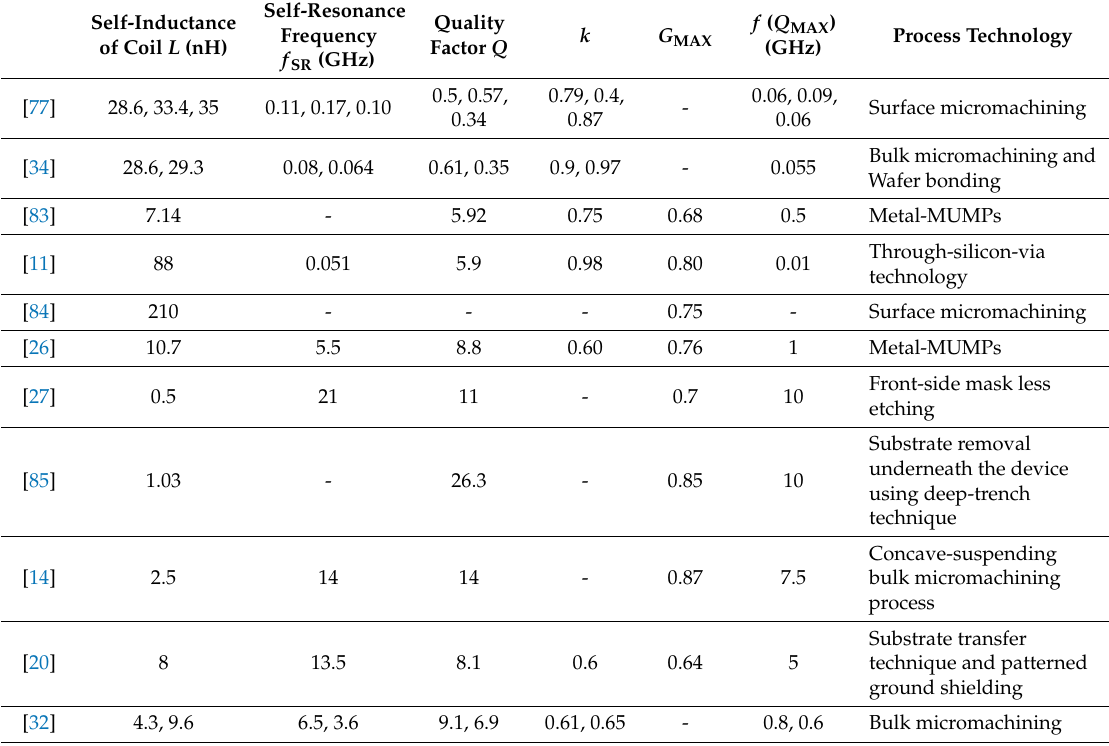
Table 3. Performance comparison of di ff erent on-chip MEMS